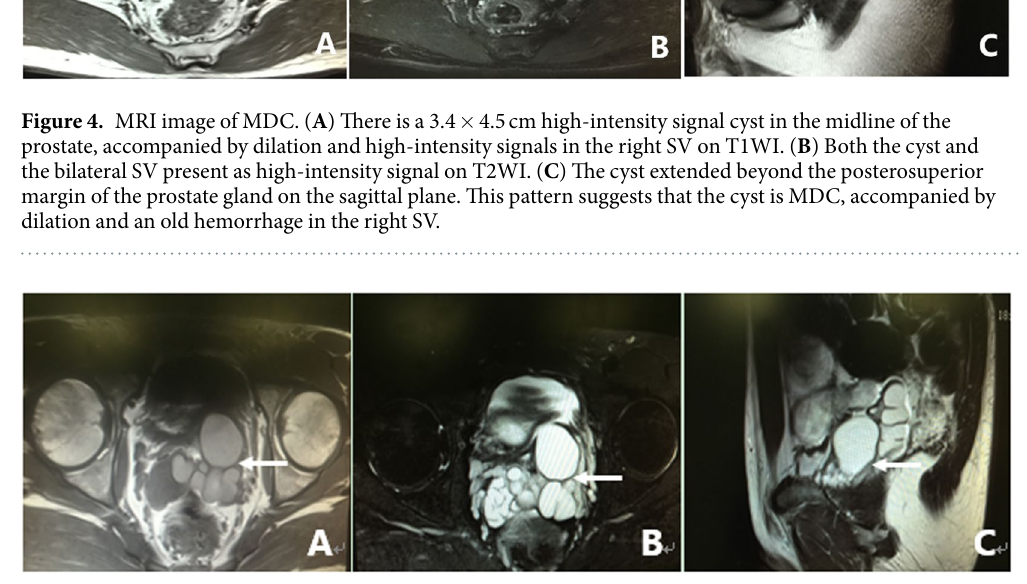
Figure 5. MRI image of SVC. ( A ) This image shows dilatation or enlargement in the left SV and presentation as a cystic structure with multiple cavities, with middle to high signal intensity in the left SV on T1WI. ( B ) This cyst presented as high signal intensity on T2WI, which is similar to that of the right SV. ( C ) The left SV presented as an obvious dilated cystic structure on the sagittal plane. This pattern suggests that the patient had a left SVC. There is also obvious dilation in the right